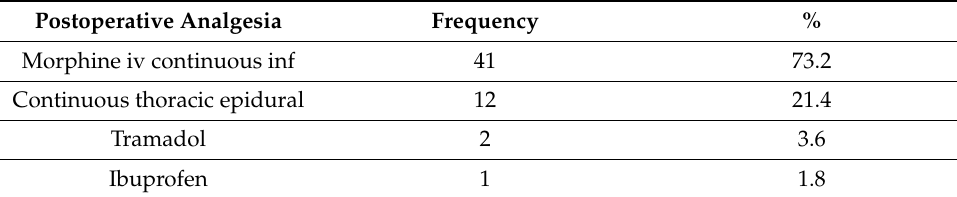
Table 2. Postoperative Analgesia.